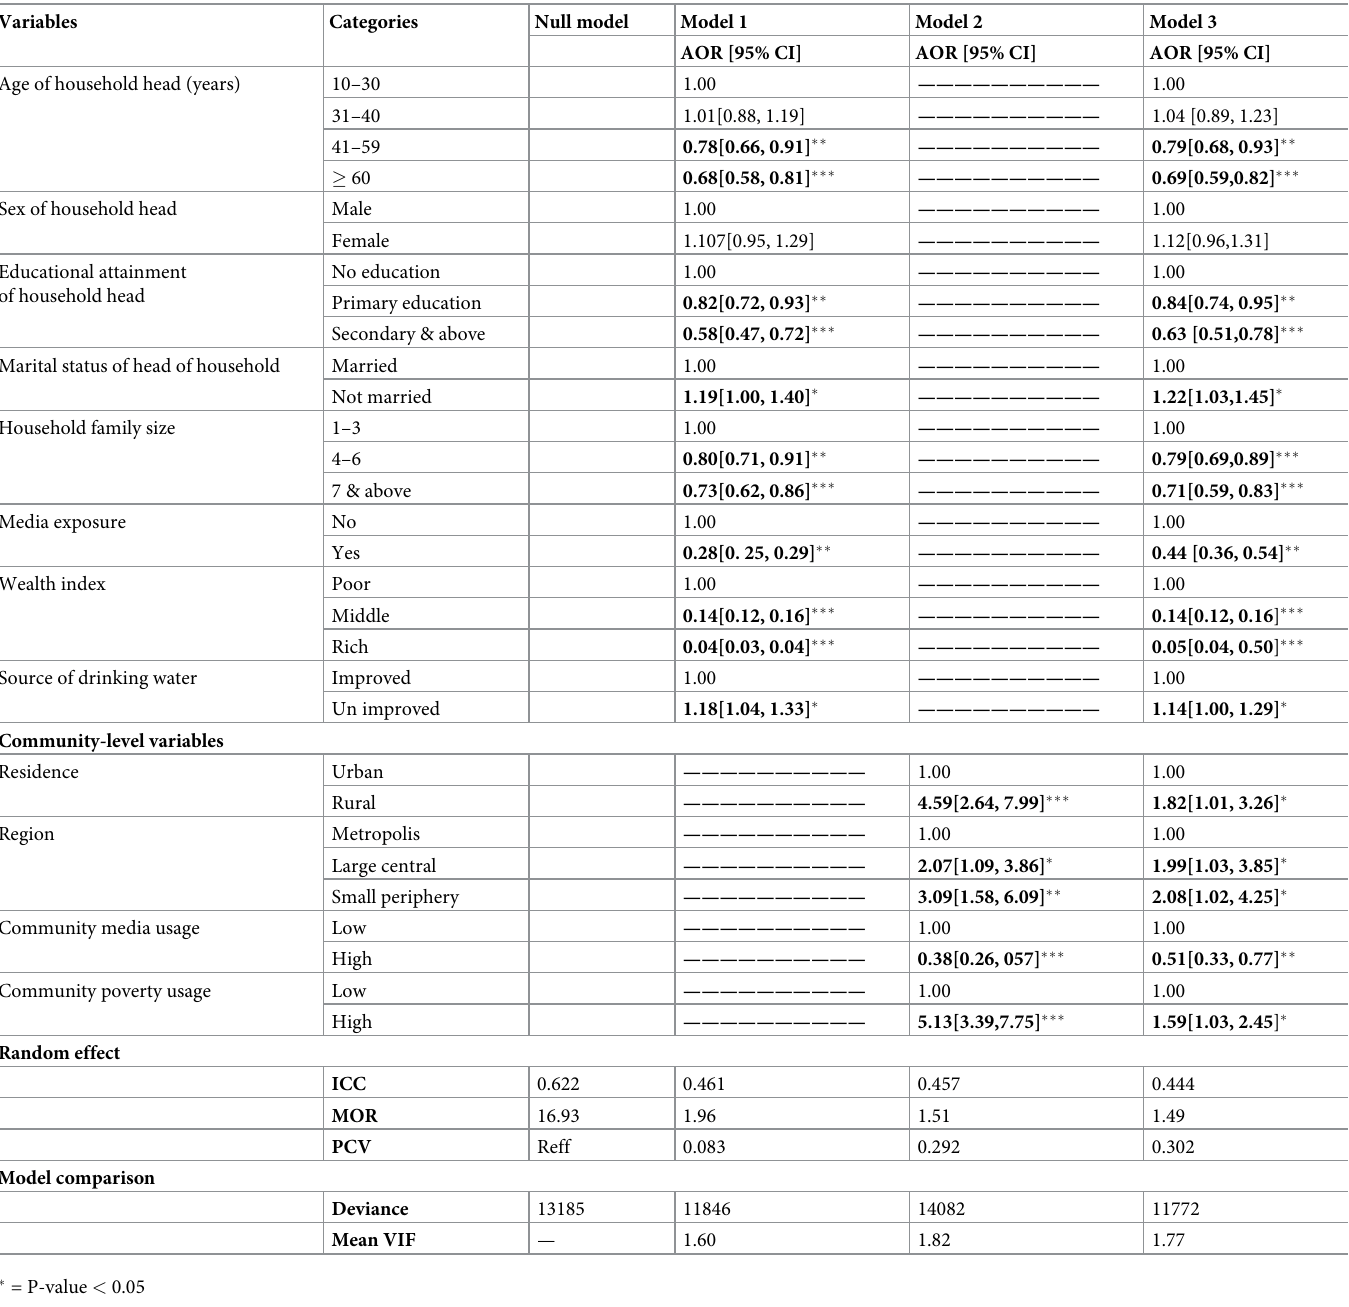
Table 2. Mixed effect analysis of factors associated with open defecation among households in Ethiopia, data from 2016